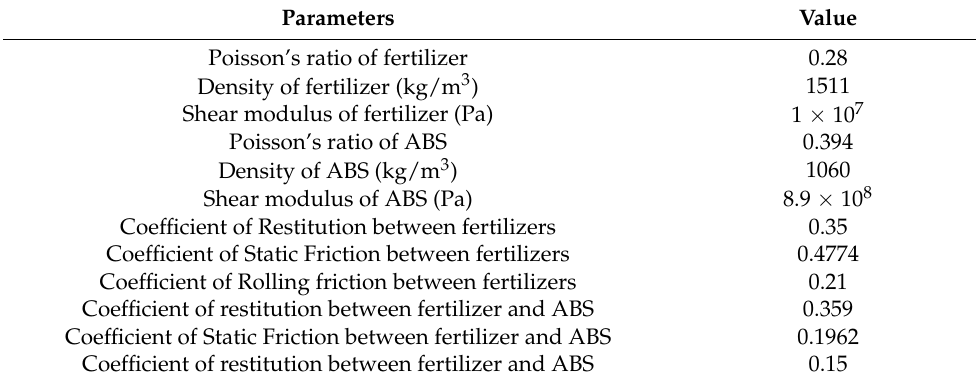
Table 1. Simulation